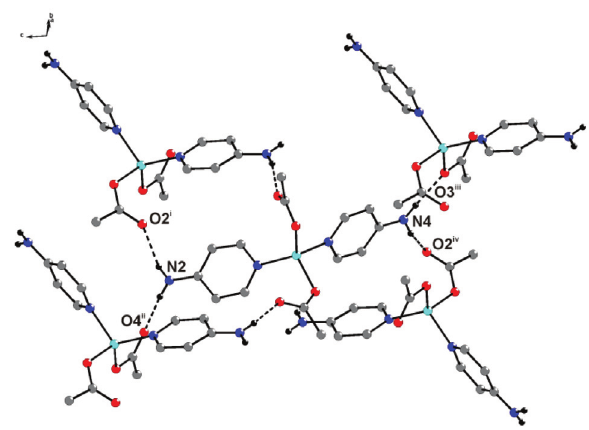
Figure 5. Hydrogen-bonding interactions in 2 . Symmetry codes: (i) – x + 1/2, y + 1/2, – z + 1/2; (ii) – x + 1/2, y – 1/2, – z + 1/2; (iii) – x + 1/2, y + 1/2, – z – 1/2; (iv) x – 1/2, – y + 1/2, z –